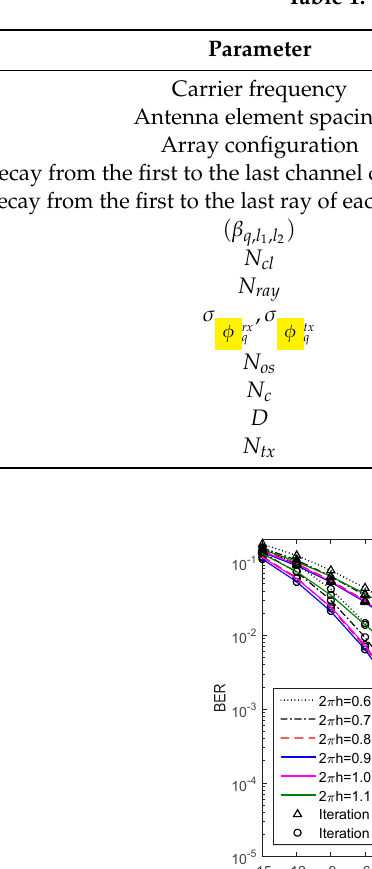
N = . N U = = and 32 rx rx